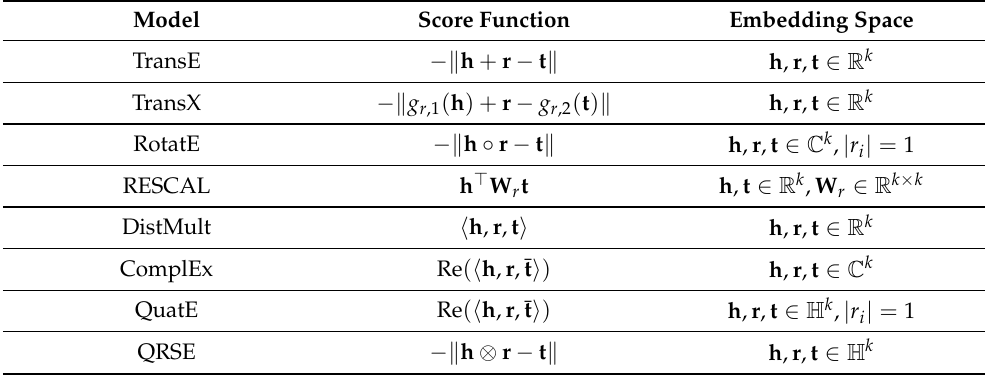
Table 1. Score functions and embedding spaces of several KGE models. (cid:104) a , b , c (cid:105) means the multi-linear dot product of vector a , b , and c ; ¯ · denotes conjugate for a complex or quaternion vectors; Re ( · ) denotes the real part of a complex number or quaternion; ⊗ indicates the Hadamard (element-wise) product between two quaternion vectors. Note that we report an equivalent formulation for QuatE to show the inheritance relationship with ComplEx.